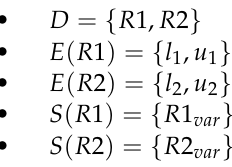
Figure 7. MPL– Initialization